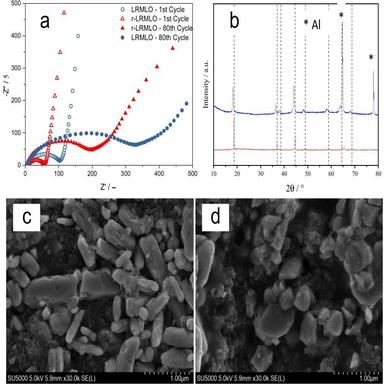
Electrochemical impedance spectrums of Li/r-LRMLO and Li/LRMLO cells in initial state and after 80 cycles at 0.1 C current rate (a); XRD patterns of r-LRMLO powder and r-LRMLO electrode after 80 cycles (b); FESEM images of r-LRMLO (c) and c-LRMLO (d) electrodes after 80 cycles.